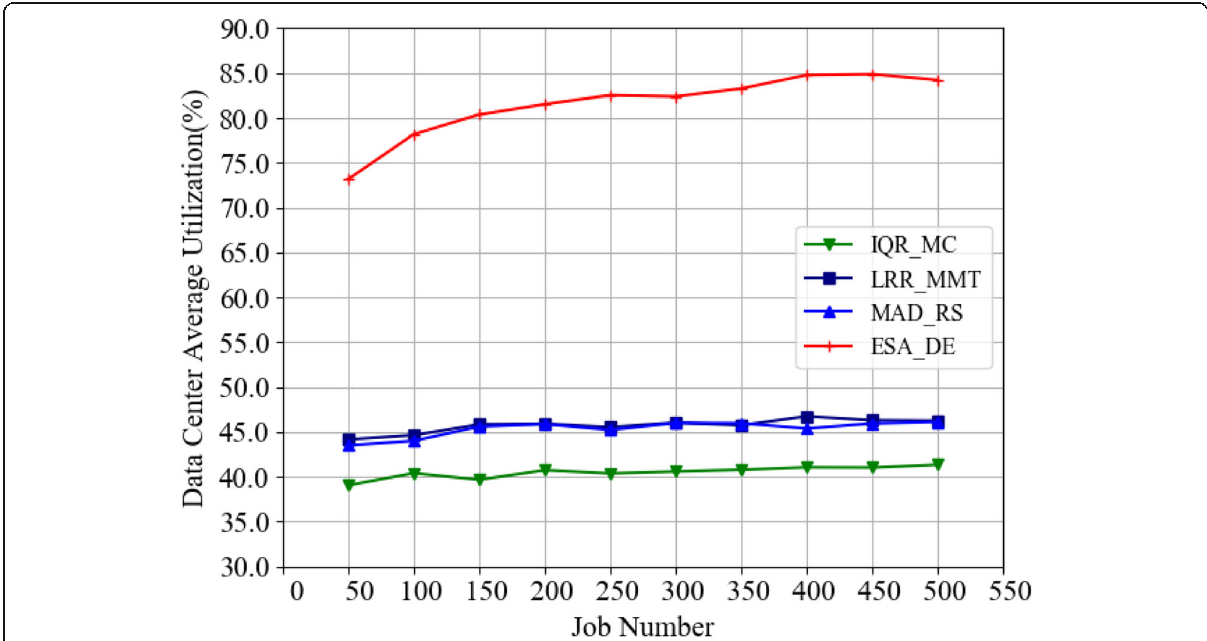
Fig. 12 Average CPU utilization of the data center under different task numbers